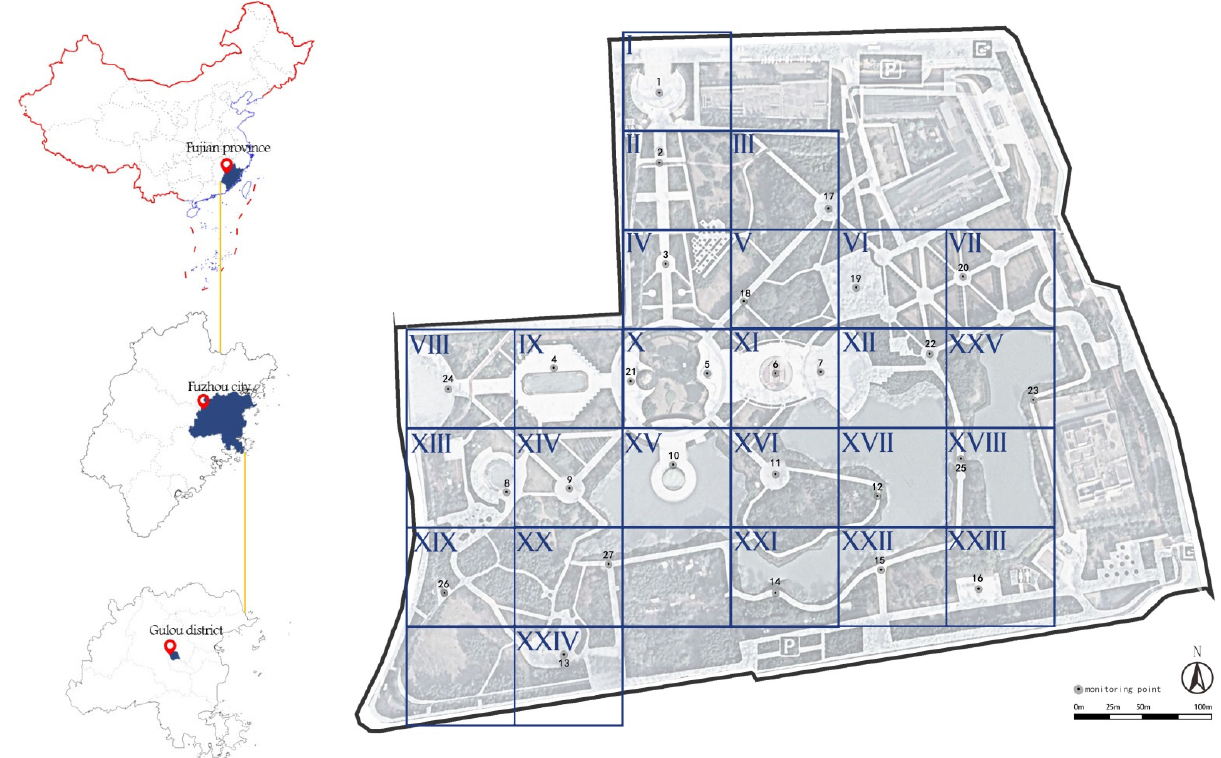
Figure 1. Area division and monitoring points of Hot Spring Park.